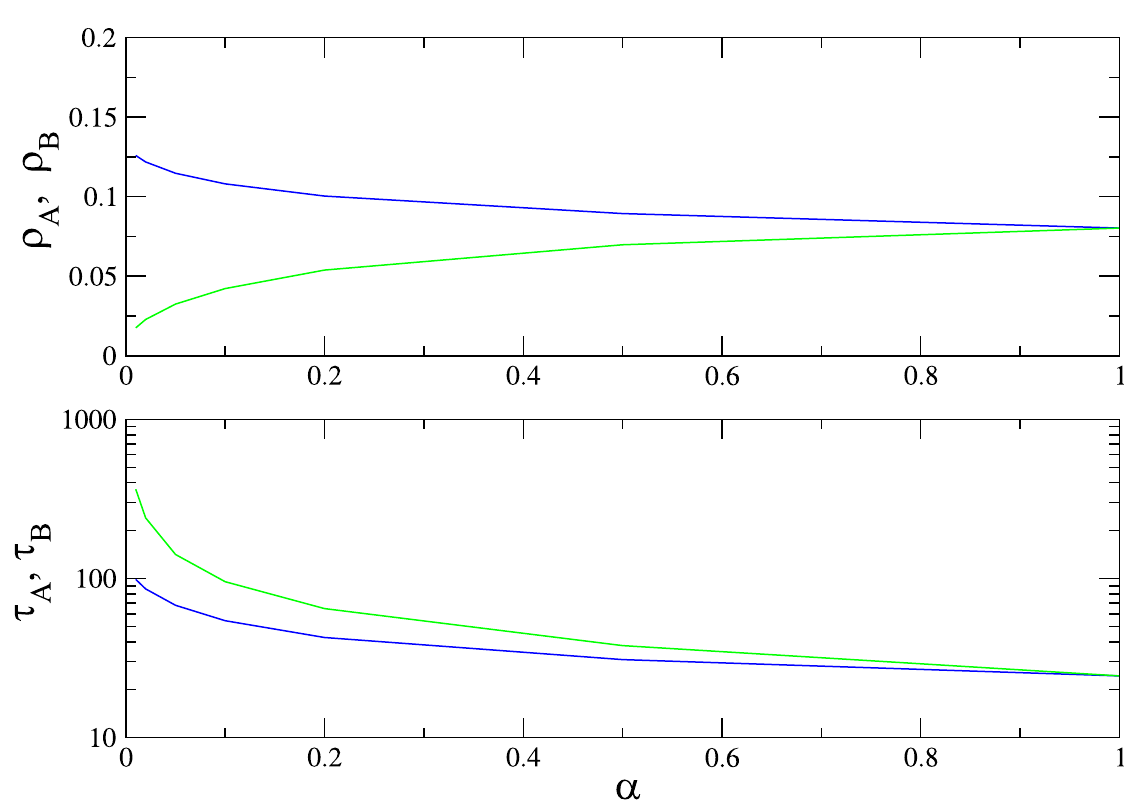
Fig 9. (Color online) Quasistationary population densities of species A (blue) and B (green) and lifetime of the QS state on a complete graph versus α , for λ = 1.2 and N = 200.